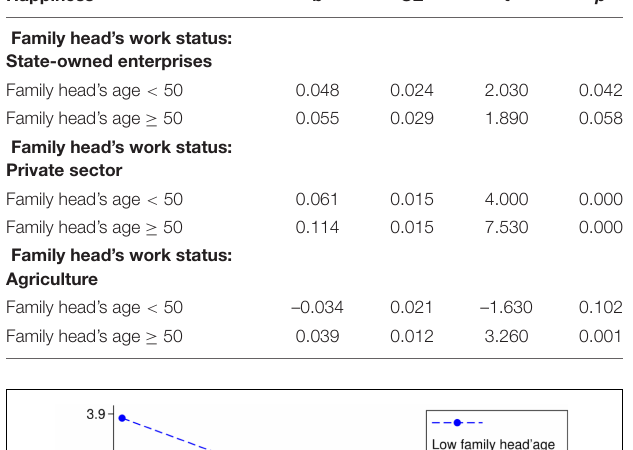
TABLE 6 | Moderating effect regression on happiness with the upward wealth inequality and the downward wealth inequality throughout the life cycle. Happiness b SE t p